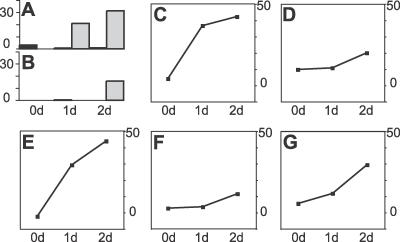
Successive Recruitment of Cells as Gametic Cells in lis-1 Gametophytes(A and B) Ectopic expression of the egg cell marker ET1119 (A) and the central cell marker pMEA::GUS (B) in wild-type and lis-1/LIS plants. Dark bars represent wild-type, light bars represent lis-1/LIS plants. The y-axis shows the percentage of ectopic expression of total GUS-staining ovules. Ectopic expression was scored zero (0d), one (1d), and two days (2d) after emasculation. Total number of ovules counted was greater than 250.(C–G) Development of five morphological features in lis-1/LIS plants as compared to wild type, zero (0d), one (1d), and two days (2d) after emasculation. The y-axis shows percent deviation from wild type (data from Table S1). (C) Synergid nuclei smaller than egg cell nucleus. (D) Different polarity of synergids and egg cell with respect to position of nucleus. (E) Polar nuclei unfused. (F) Ectopic cellularization. (G) Protruded antipodal cells.